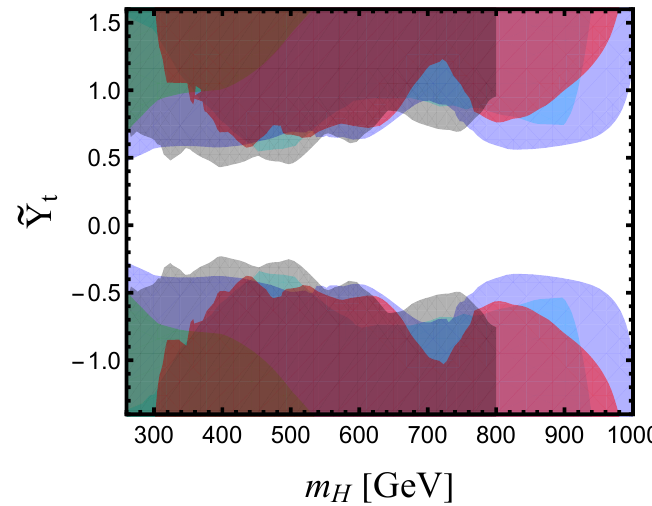
Figure 17 . Current limits in top quark Yukawa coupling in Zee model in ~ Y t (cid:0) m H plane from SM Higgs observables as well as Heavy Higgs searches. Gray, red and cyan shaded regions are excluded from current di-Higgs limit looking at di(cid:11)erent (cid:12)nal states b (cid:22) b(cid:13)(cid:13) [94], b (cid:22) bb (cid:22) b [95] and b (cid:22) b(cid:28) + (cid:28) (cid:0) [96] respectively; blue and green shaded zones are excluded from the resonant ZZ and W + W (cid:0) searches [97,